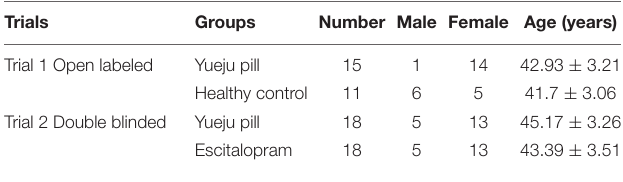
TABLE 1 | Demographic data of the enrolled subjects with MDD or healthy